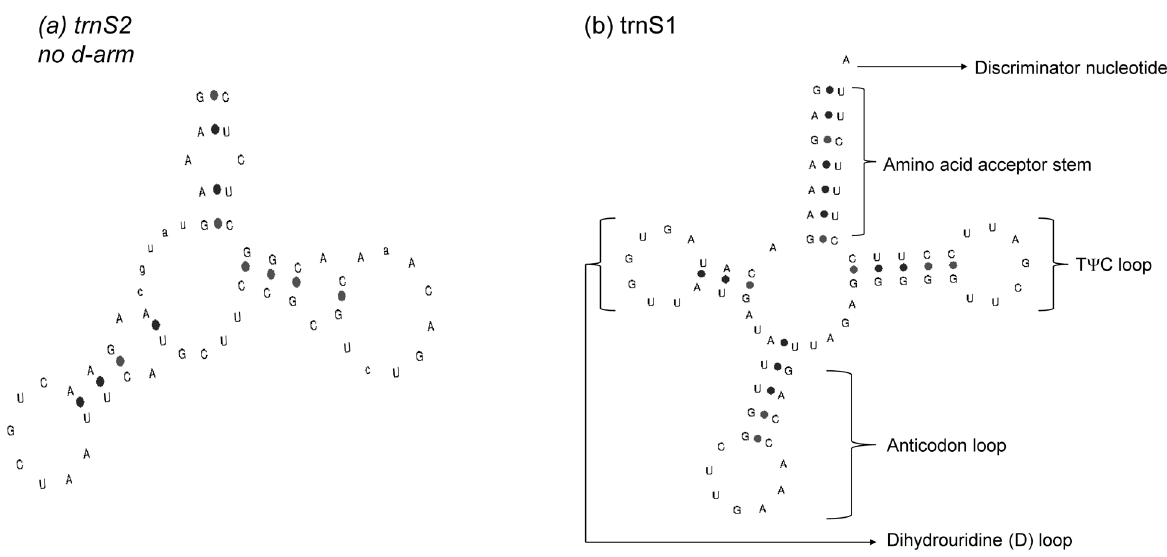
Figure 4. Secondary structure of tRNA-Ser.